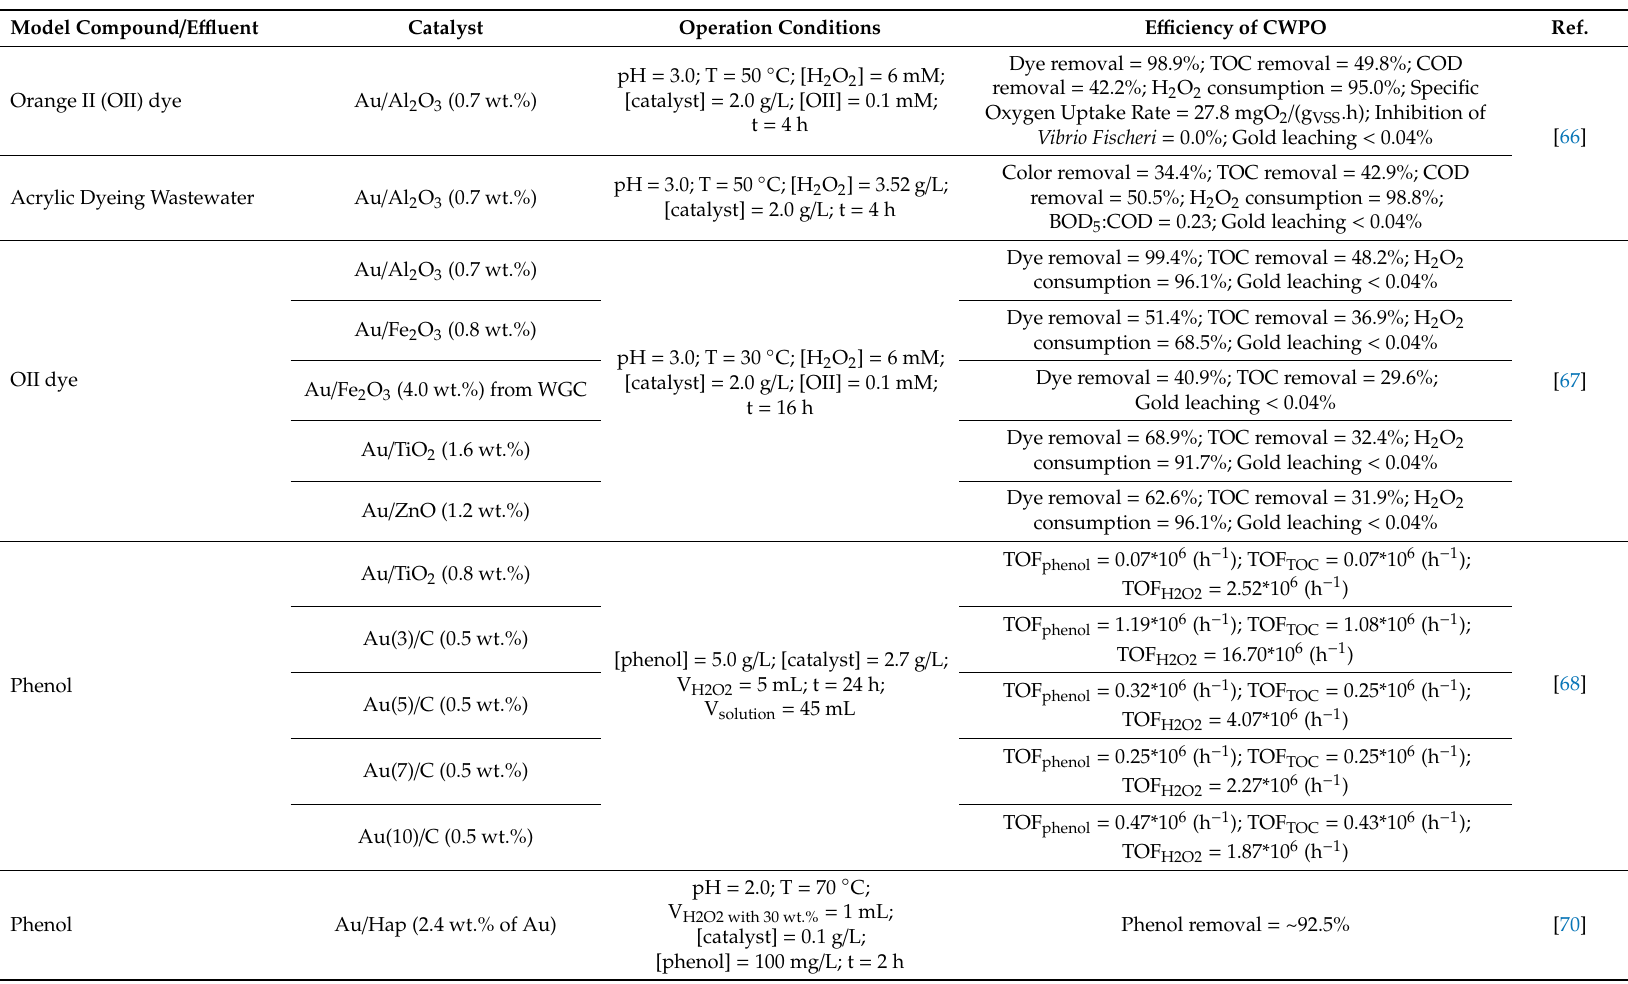
Table 2. Gold catalyst used in CWPO of model compounds degradation or wastewater treatment, operational conditions, and performances reached. Model Compound / E ffl